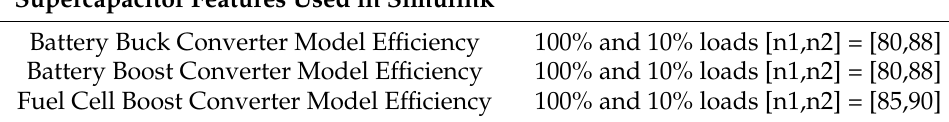
Table 2. DC/DC converter